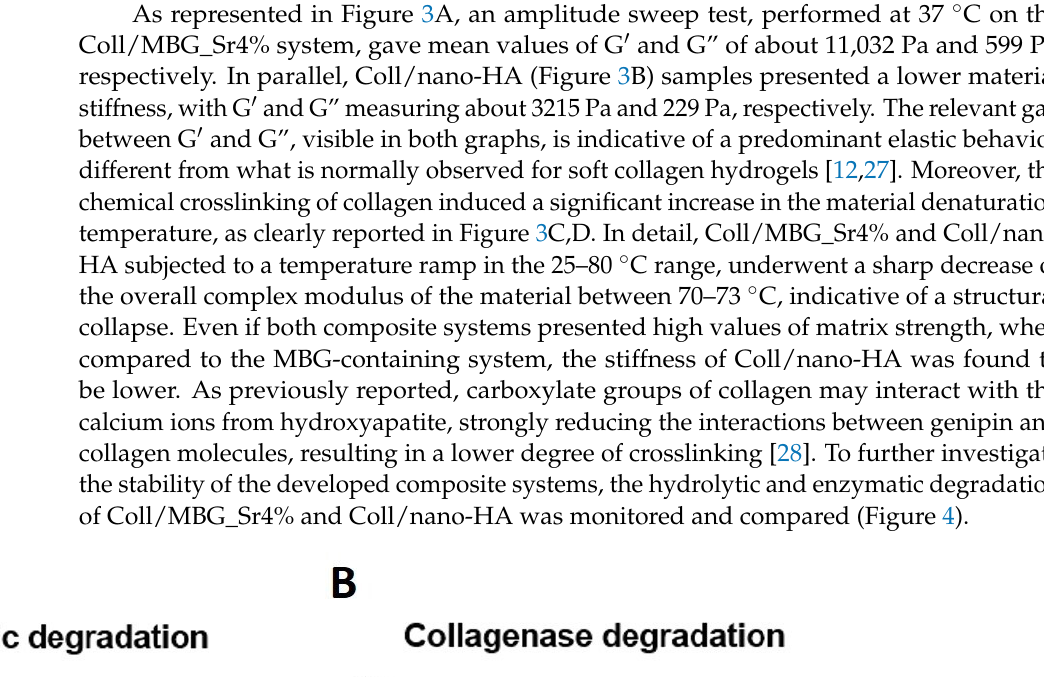
Figure 3. Viscoelastic properties of the composite systems: material strength ( A , B ) and denatura- tion temperature ( C , D ).